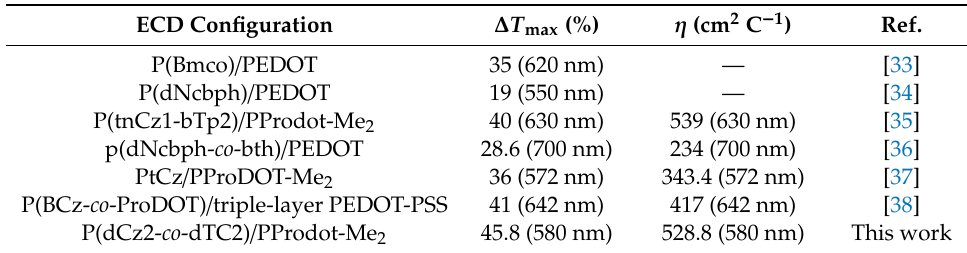
Table 6. Optical contrast and coloration e ffi ciencies of some